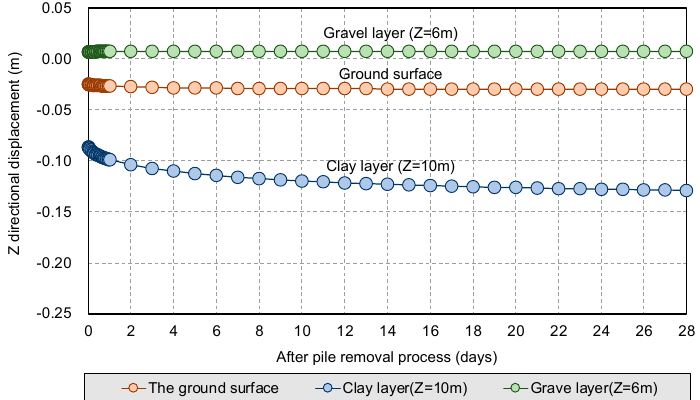
Figure 4. Subsidence of the surrounding ground during the process of forming one extraction hole of a removed pile.